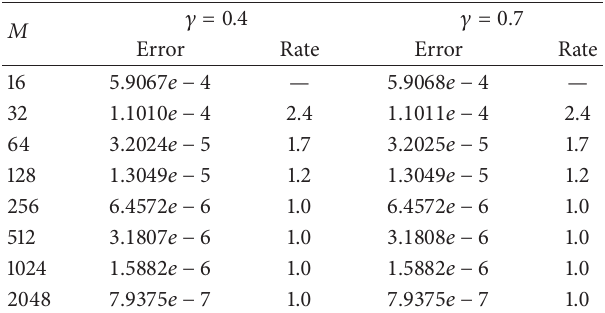
Table 4: Rate for time for 𝑔(𝑥) = 𝑥 𝜇 1 − 𝑥 𝜇 2 with 𝜇 1 = 7/2 , 𝜇 2 = 7/3 for Example 7 using 3rd-order